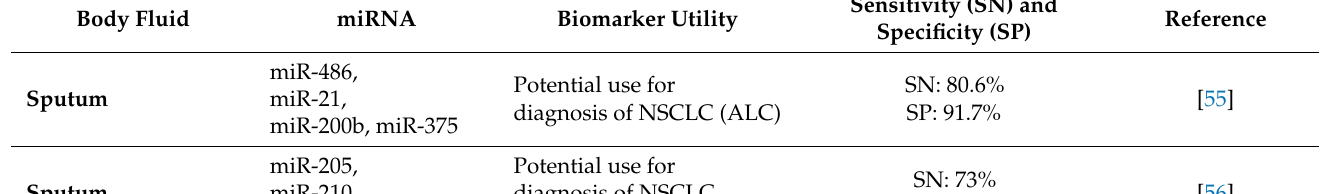
Table 1. Summary of studies showing miRNAs from different biofluid sources as potential biomarkers in